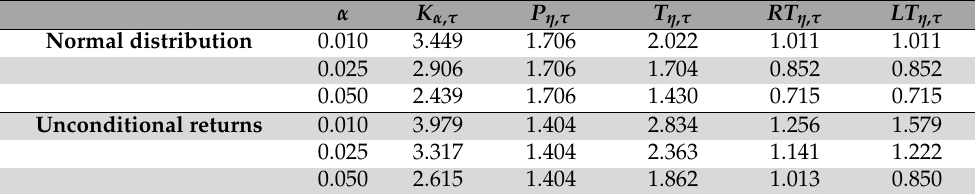
Table 2. Comparison of quantile–based kurtosis, peakedness and